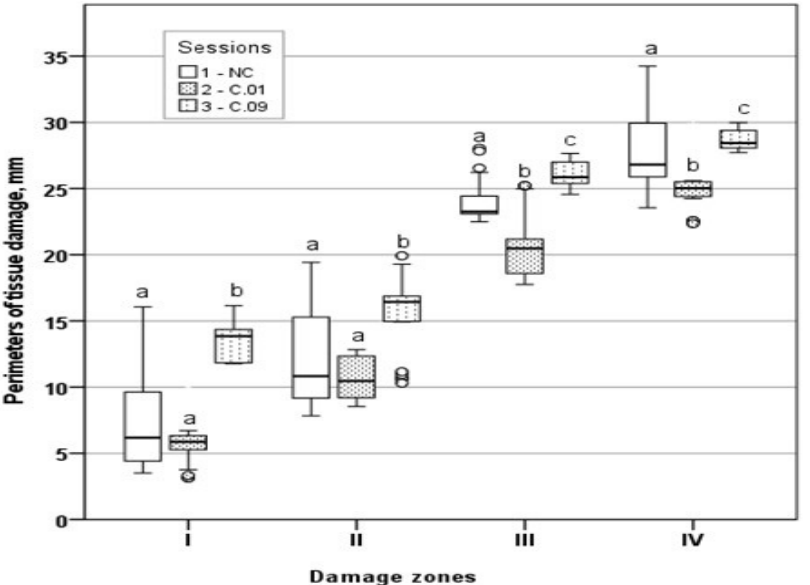
Figure 7. Graphical comparison of tissue damage perimeter distributions by zones. a, b, c—the distributions differed statistically significantly as found by a non-parametric Kruskal–Wallis test.